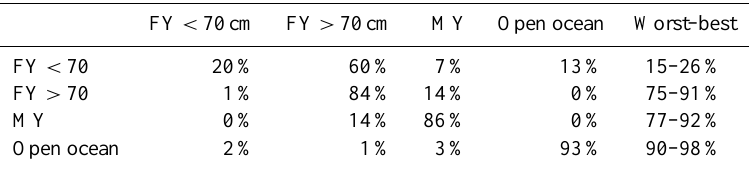
Table 2. Classification matrix of CS-2-based classification (rows) and AARI ice chart (columns), March 2014. Last column shows the best and the worst hit rates of the three 5-day